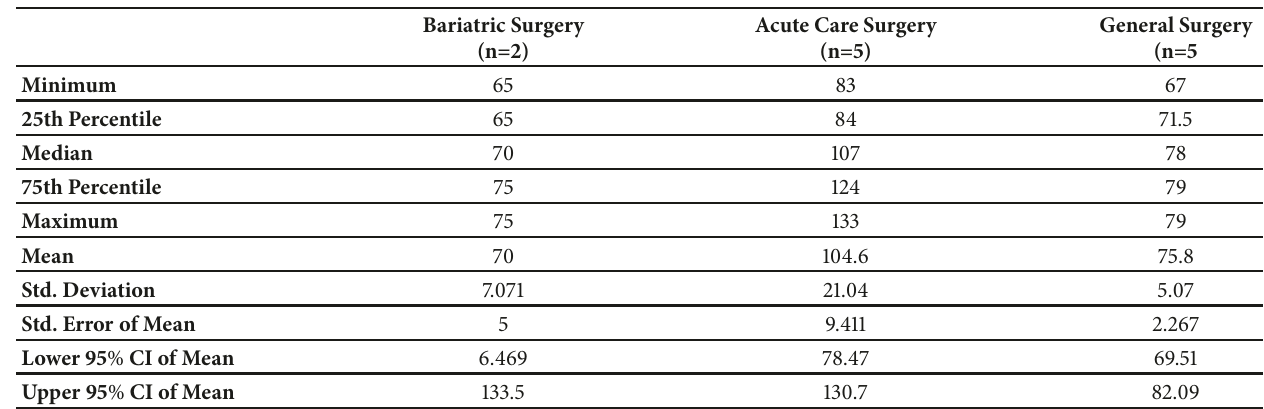
Table 2: Case duration analysis.